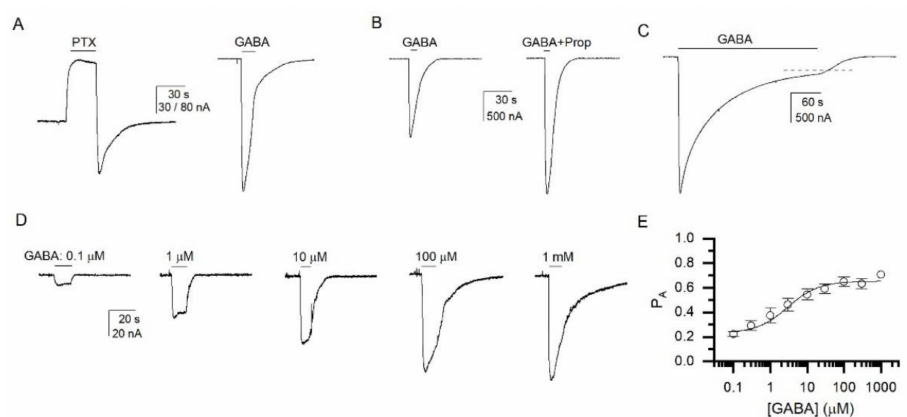
Figure 1. Basic characterization of properties of the α 1 β 2 ε GABA A receptor. ( A ) Sample current responses to 200 µ M picrotoxin (PTX) and 1 mM GABA. ( B ) Sample current responses to 1 mM GABA and 1 mM GABA + 10 µ M propofol (Prop). In panels ( A , B ), the paired current responses are from the same cells. ( C ) Sample current response to a prolonged application of 1 mM GABA. The dashed line shows the fitted level of steady-state current. ( D ) Sample current responses to 0.1 µ M, 1 µ M, 10 µ M, 100 µ M, and 1 mM GABA. All traces are from the same cell. ( E ) The GABA concentration-response relationship. The data are expressed in the units of P A . The data points give means ± S.D. from seven cells. The curve is calculated using the mean K R,GABA (4.2 µ M) and c GABA (0.399) values with the number of GABA binding sites constrained to